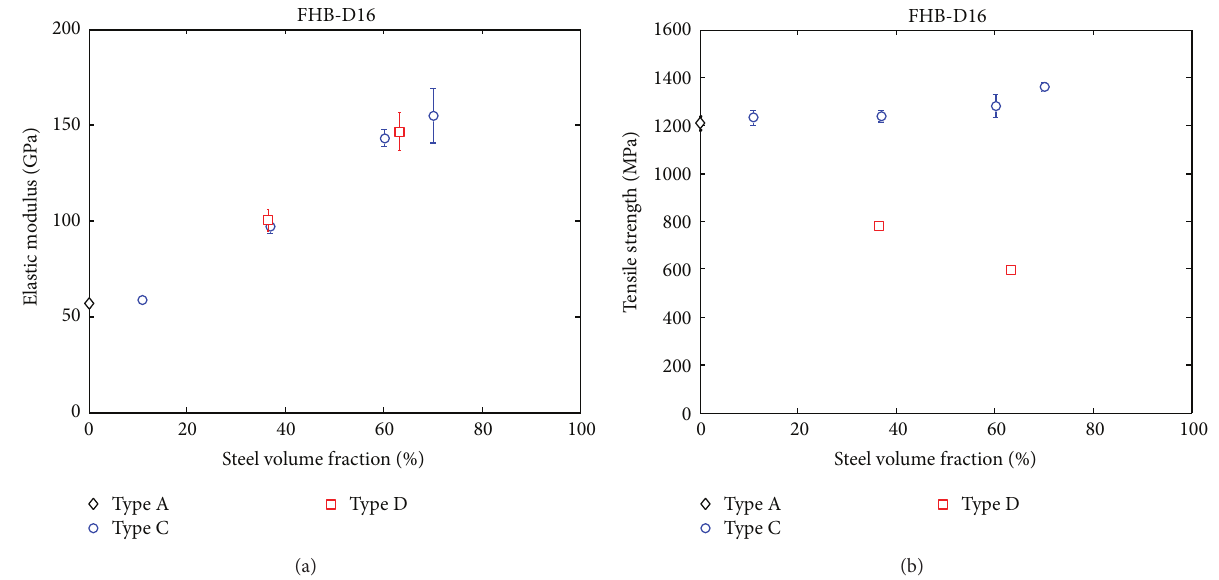
Figure 15: Test results for D16 FRP Hybrid Bar: (a) elastic modulus; (b) tensile strength.